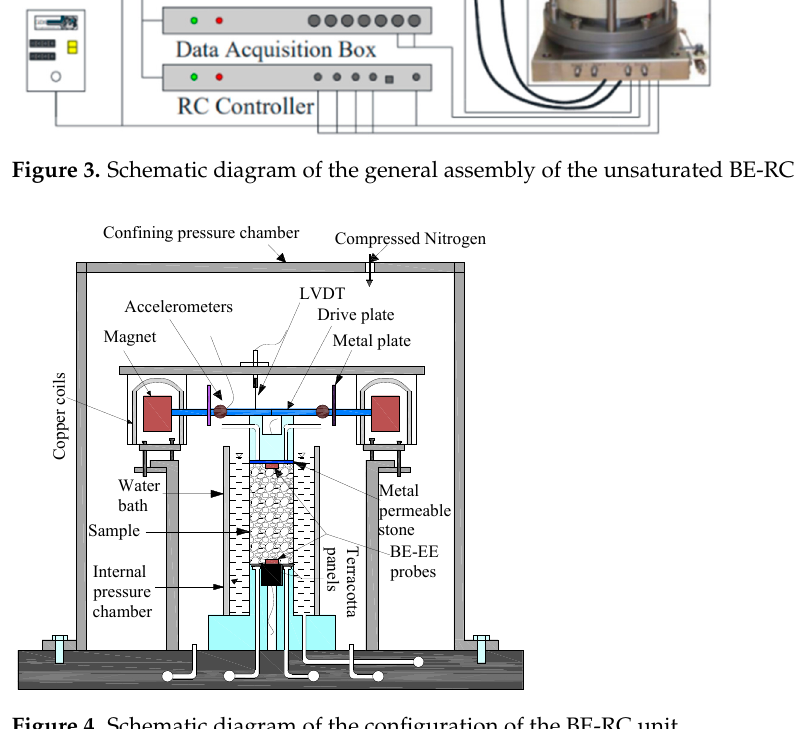
Figure 4. Schematic diagram of the configuration of the BE-RC unit.